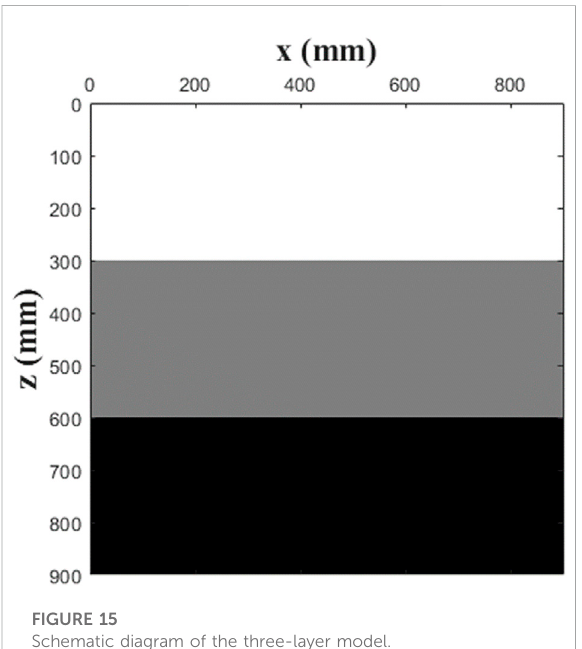
FIGURE 15 Schematic diagram of the three-layer model.